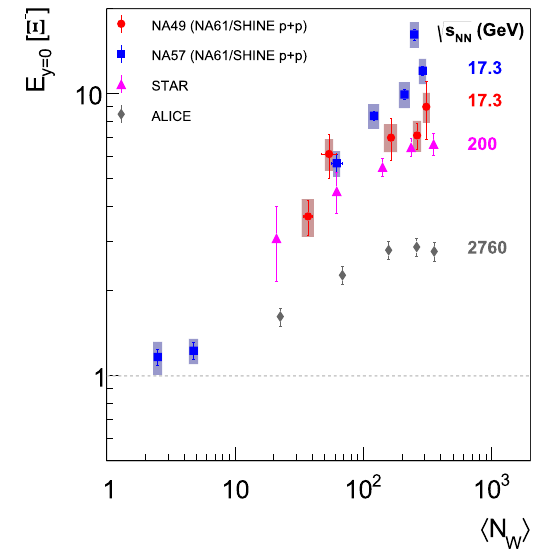
158 A GeV [27], blue squares – NA57 p +Be, p +Pb and Pb-Pb at the √ s NN = 17.3 GeV [25], magenta triangles same center-of-mass energy √ s NN = 200 GeV [28], gray diamonds – ALICE - STAR Au+Au at